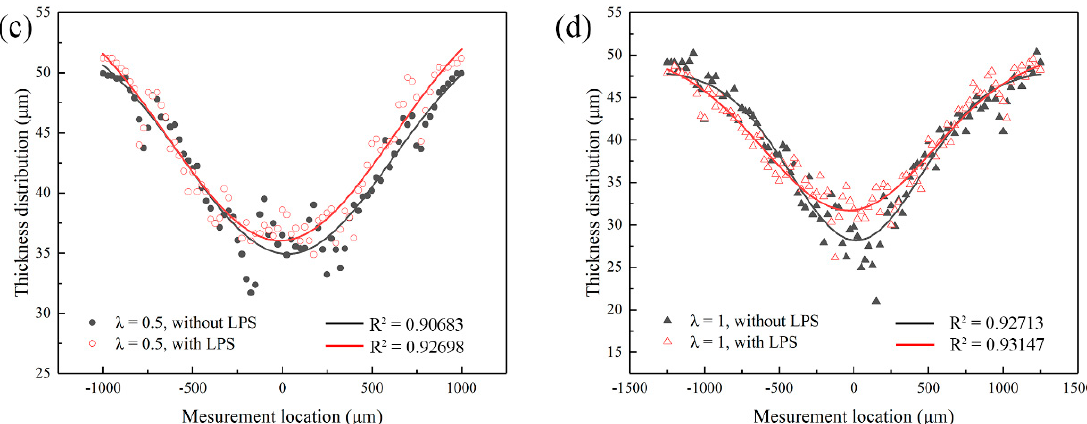
Figure 15. Effects of LPS and mold characteristic size on the thickness distribution of bulging samples annealed at 450 ◦ C under laser pulse energy of 447 mJ. ( a ) Samples without LPS, λ = 0.25, 0.5, 1; ( b ) samples with and without LPS, λ = 0.25; ( c ) samples with and without LPS, λ = 0.5; ( d ) samples with and without LPS, λ = 1.